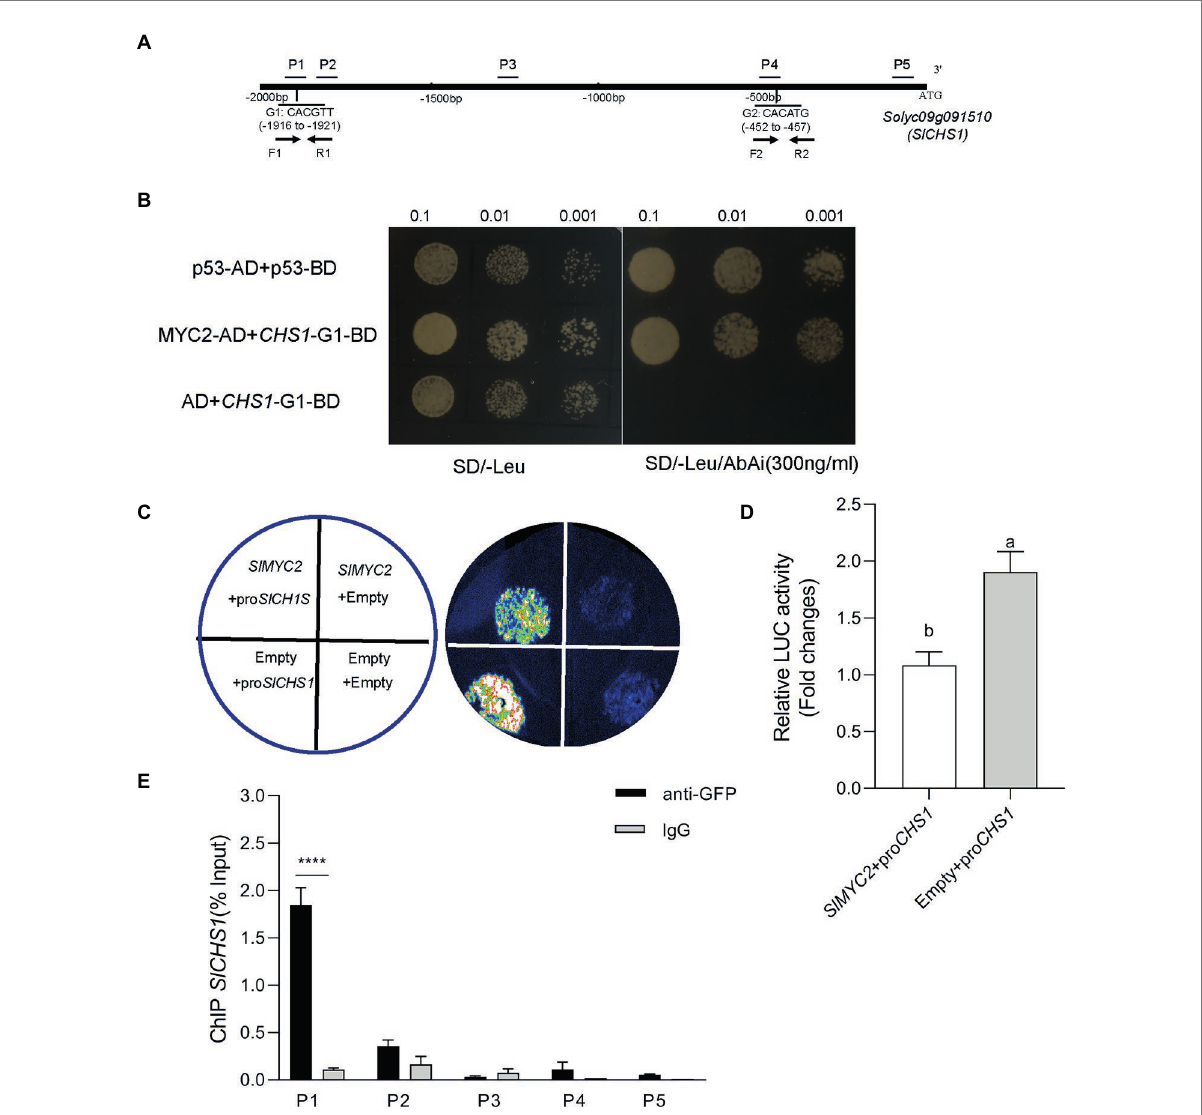
FIGURE 2 SlMYC2 directly binds to the SlCHS1 promoter. (A) The distribution of fragments of the SlCHS1 promoter (P1–P5) used in ChIP–qPCR assays and two G-box motifs tested in the Y1H assay (G1 and G2). (B) Interaction of SlMYC2 with the SlCHS1 promoter fragments in the Y1H assay. (C,D) Effects of SlMYC2 on the SlCHS1 promoter in the dual-luciferase assay. (E) ChIP–qPCR was used to analyse the recruitment of SlMYC2 to the SlCHS1 promoter region. Different letters indicate significant differences ( p < 0.01) determined using Student’s t test. Asterisks represent significant differences (**** p < 0.0001) determined using Tukey’s multiple comparisons